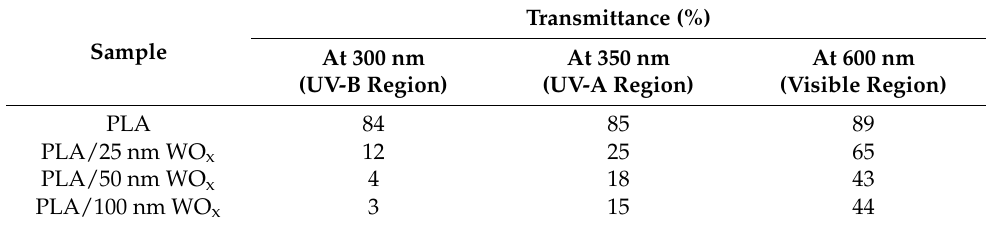
Figure 8. Uncoated PLA exhibits a permeability of 290 × 10 − 16 cm 3 · cm/cm 2 · s · Pa.